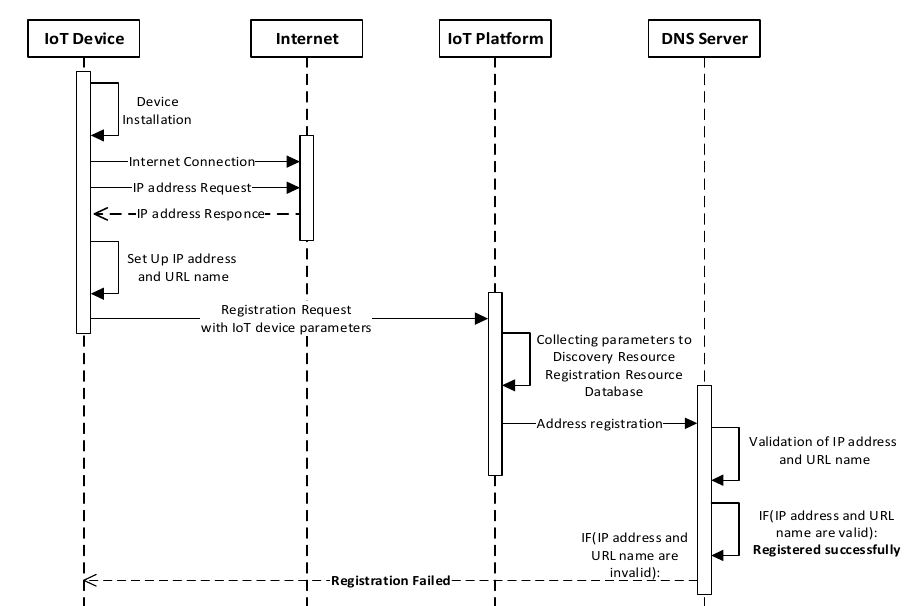
Figure 6. IoT device registration sequence diagram of the proposed system.